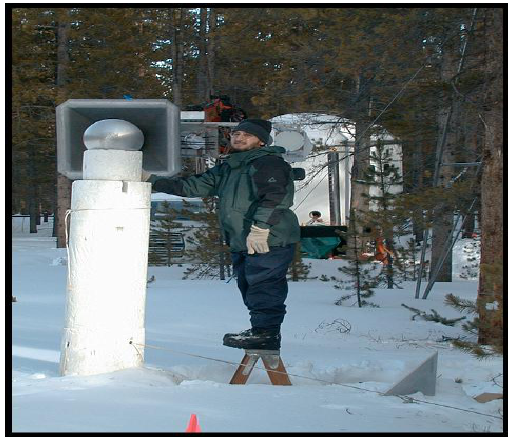
Figure 2 . A typical metallic sphere for calibration purpose (Saint-Martin et al, 2003)